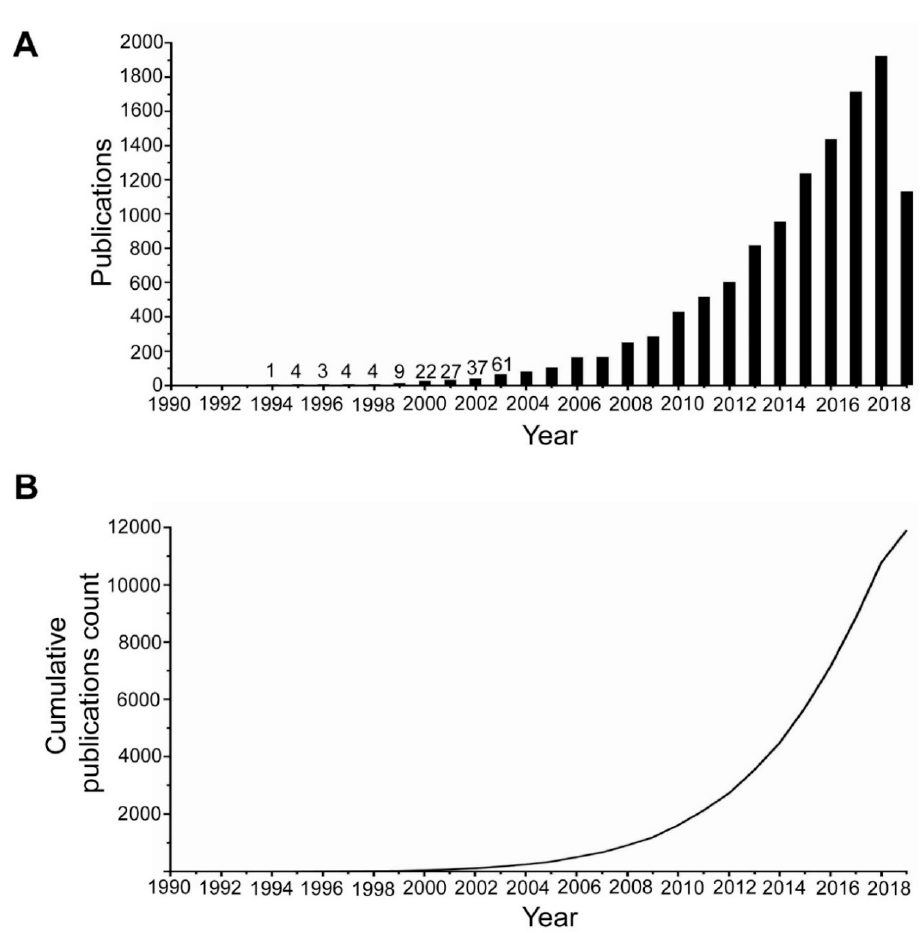
Figure 1. ( A ) Number of publications about Nrf2 per year. The numbers on top of the first bars indicate the exact number of publications for the respective year. Data up to July 2019. ( B ) Cumulative number of publications about Nrf2 per year. Data up to July